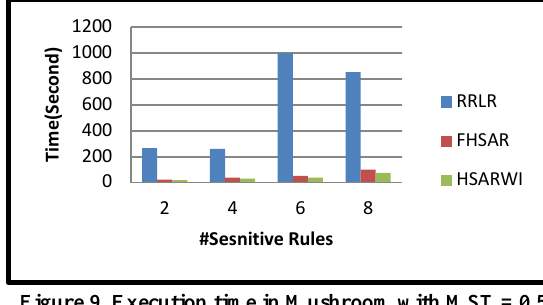
Figure 9. Execution time in Mushroom with MST = 0.5 and MCT = 0.75